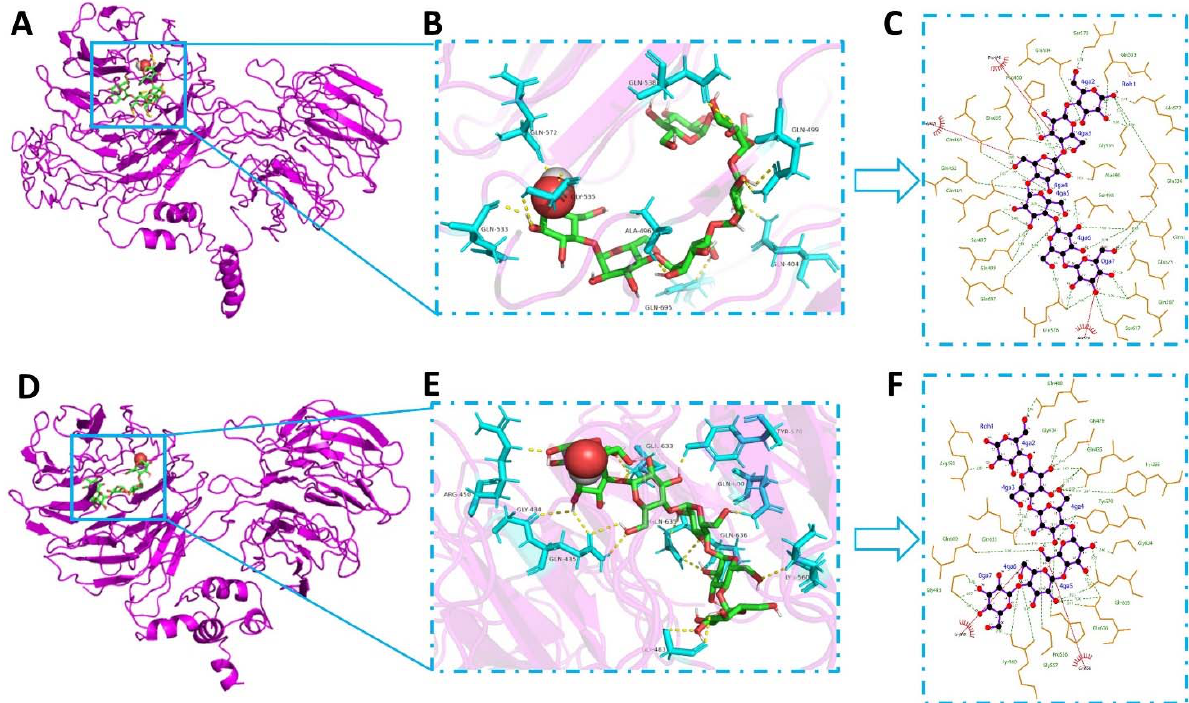
Figure 4. Molecular docking of HMW-GSs (Y16 and Y22) with starch. ( A , D ) represent the docking conformations of starch with HMW-GSs from Y16 and Y22, respectively. ( B , E ) represent the non- bonding interaction of corresponding docking conformations, and ( C , F ) represent the 2-D interaction of corresponding docking conformations.